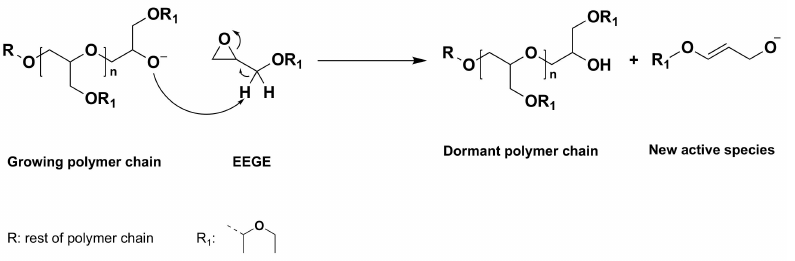
Figure 5. Possible mechanism of chain transfer reactions during the anionic polymerization of EEGE using alkali metal alkoxide initiators. Adapted with permission from ref. [40]. Copyright 2009